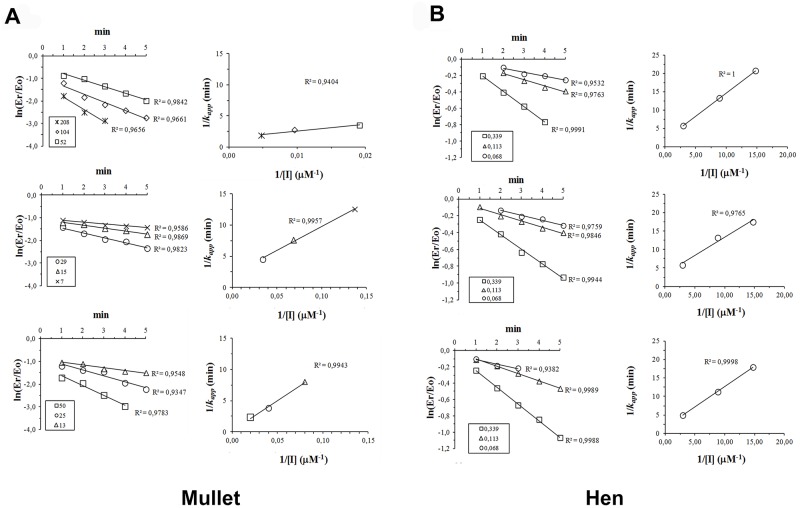
kapp determination plots (graphs on the left) and replots (graphs on the right) for the inhibition kinetic constants (IKC) for methylparaoxon (MP) inhibition of brain AChE from three M.liza (A) and three G. domesticus (B).The boxes show methylparaoxon (MP) concentrations (μM). Each point for the kapp determination represents an individual enzyme assay.